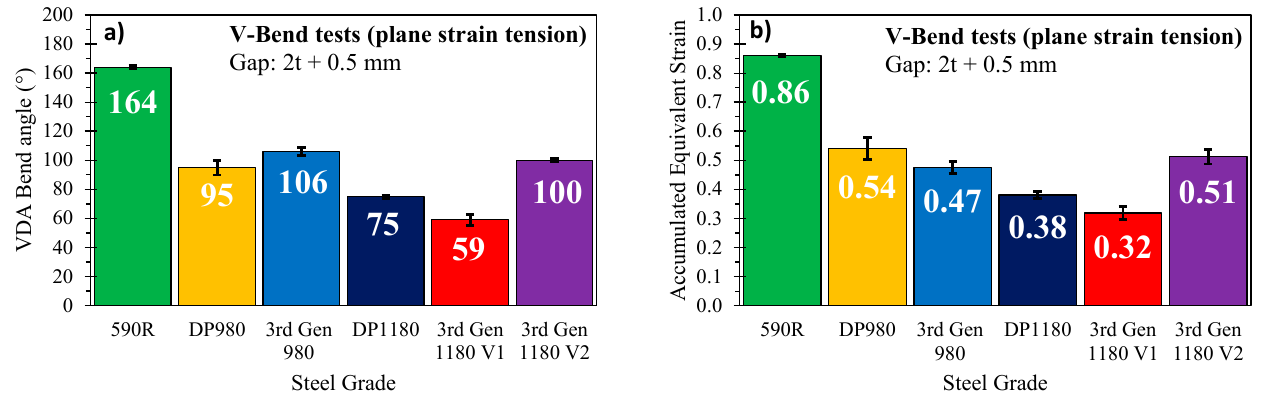
Figure 26. Failure bend angles ( a ) and equivalent strains ( b ) under plane strain tension. Note that the data for the plane strain fracture strain of the same lot of the DP1180 was reported in Noder et al. [13] for a von Mises material and was integrated using the Barlat Yld2000 plasticity model as part of this